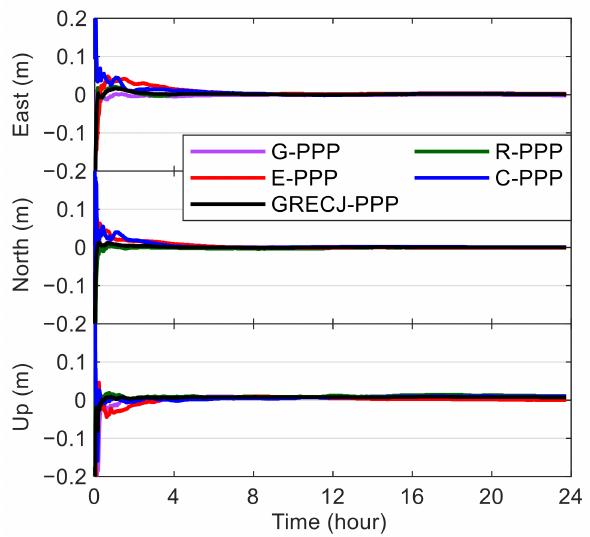
Figure 10. Epoch-wise position errors of static PPP using ESA final precise products at station KIR0